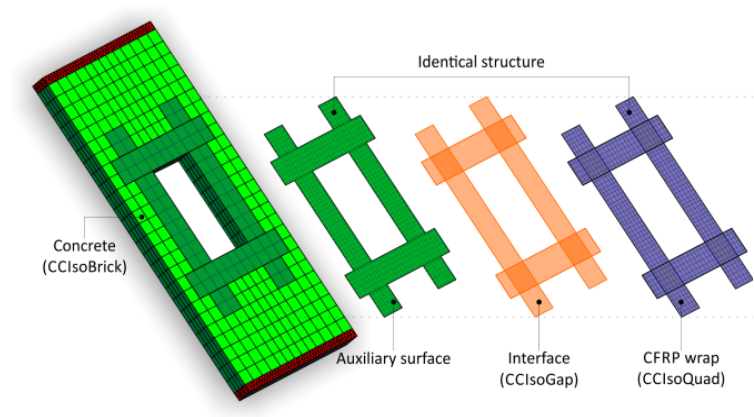
Figure 6. Strengthening process of the developed